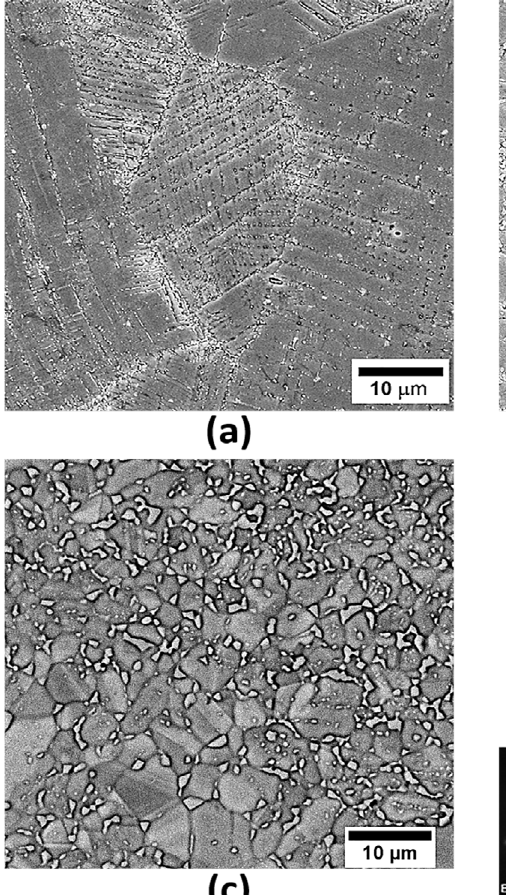
and [112] zone bcc bcc